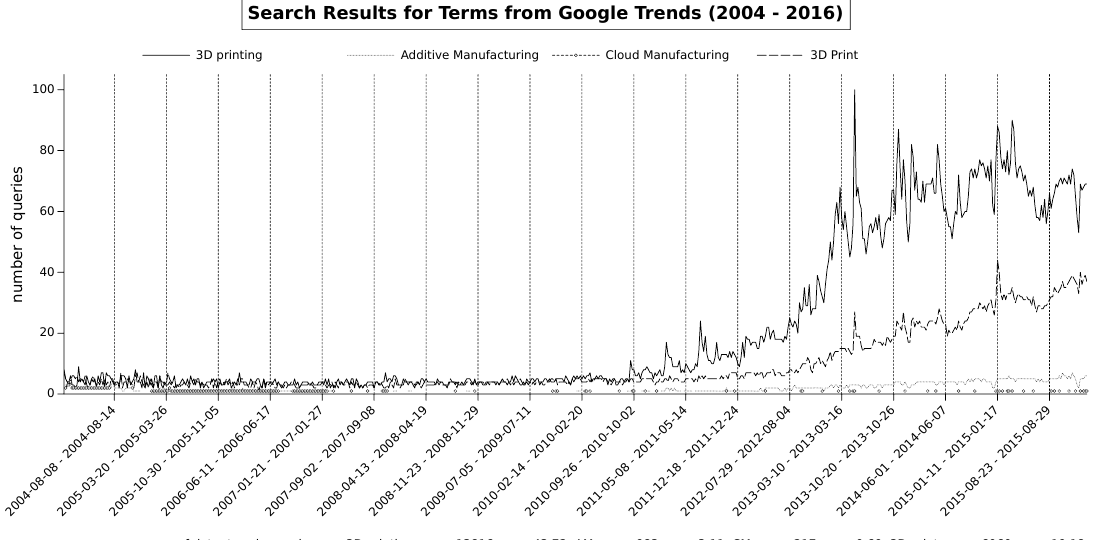
Figure 1. Queries for 3D Printing, AM, CM and 3D Print on google.com for 2004–2016 from trends.